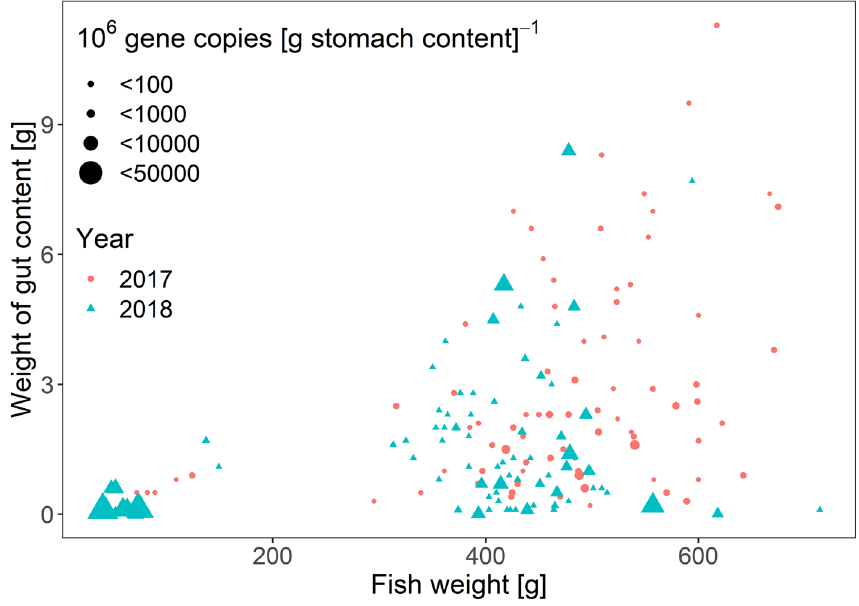
Figure 4. Number of herring mt16S gene copies in mackerel stomachs (size of symbols) in 2017 and 2018 as a function of mackerel whole body (fish) weight and weight of gut